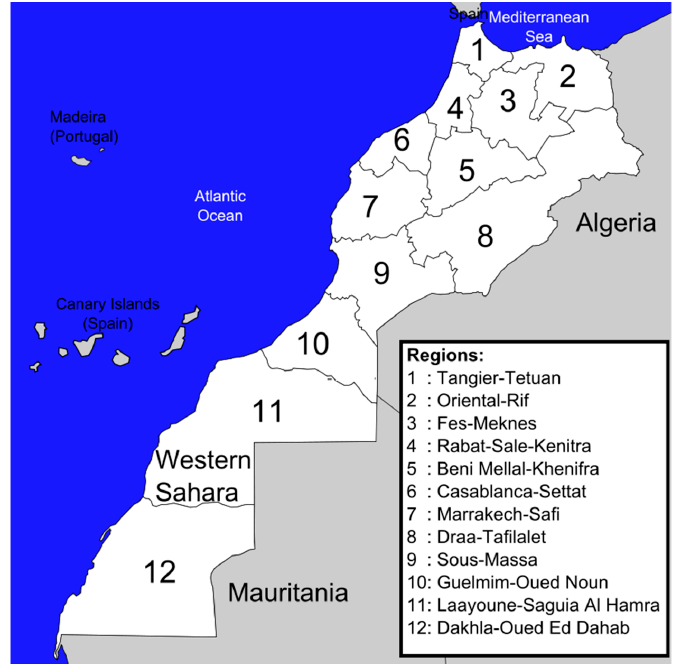
Figure 2. Regional Divisions in Morocco by Zone Code [16]. Table 1. Regional Distribution in Morocco.